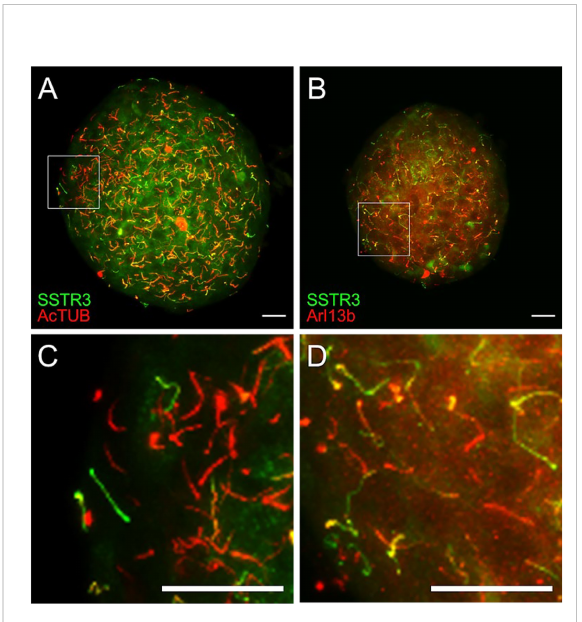
FIGURE 5 Validation of SSTR3-GFP cilia reporter by immunostaining. (A, B) Maximal confocal projections of whole islets from beta cell green cilia reporter SSTR3-GFP mice labeled with acetylated a - tubulin (AcTUB) or Arl13b in red. Green and yellow correspond to beta cell cilia; red represents non-beta cell cilia. (C, D) Magni fi ed inset images from panels A and B, respectively. Scale bars, 20 µm.